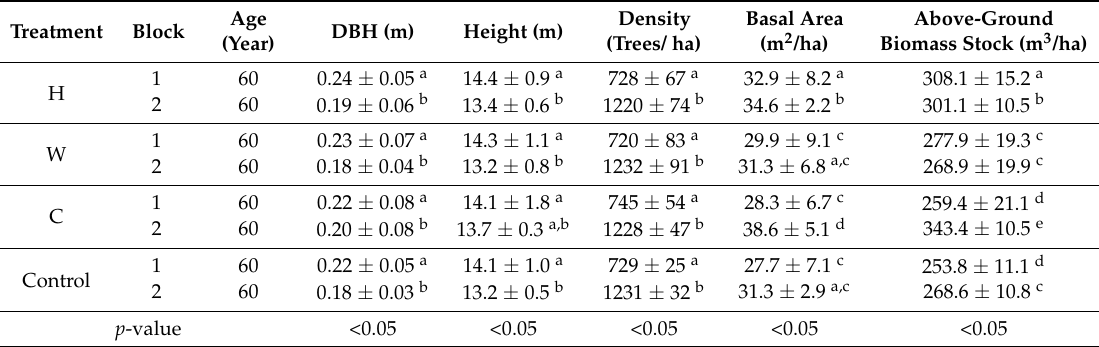
Table 4. Main dendrometric characteristics of the pine forest before cutting (ANOVA test, df 3, 40; average ± SD). DBH: diameters at breast